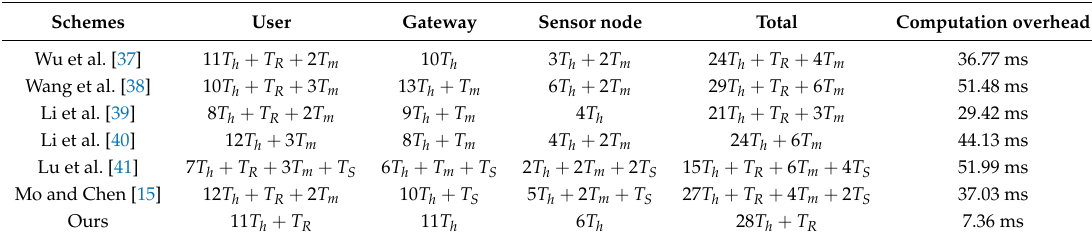
Table 5. Computation overheads comparison.